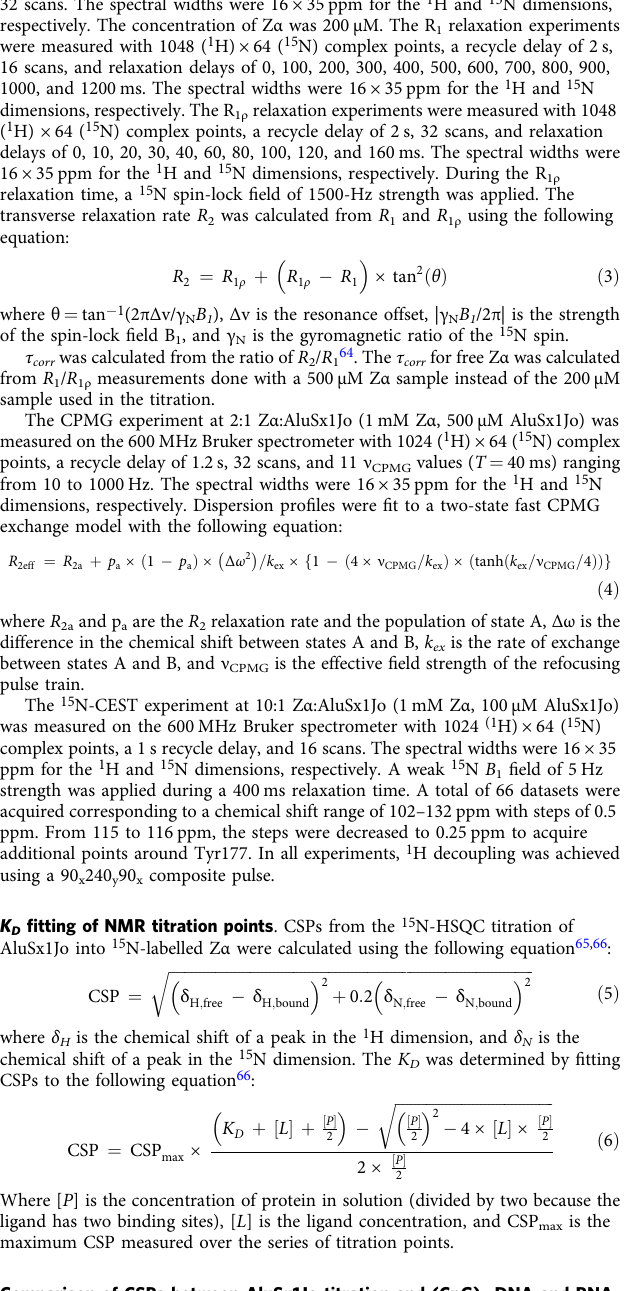
(Fig. 4) were predicted within RNAeval using default parameters 46 (last accessed at http://rna.tbi.univie.ac.at on September 10, 2020) and plotted vs. base-pair identity. The regions identi fi ed as being bound and destabilized by Z α binding were over- layed over the